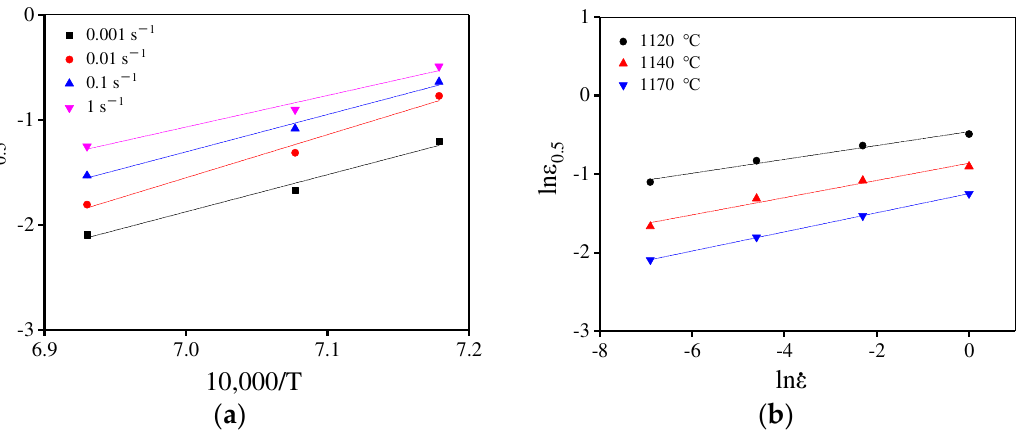
Figure 15. Relationship between ε 0.5 and deformation parameters ( a ) ln ε 0.5 –10,000/T and ( b ) ln ε 0.5 − ln ɺ .